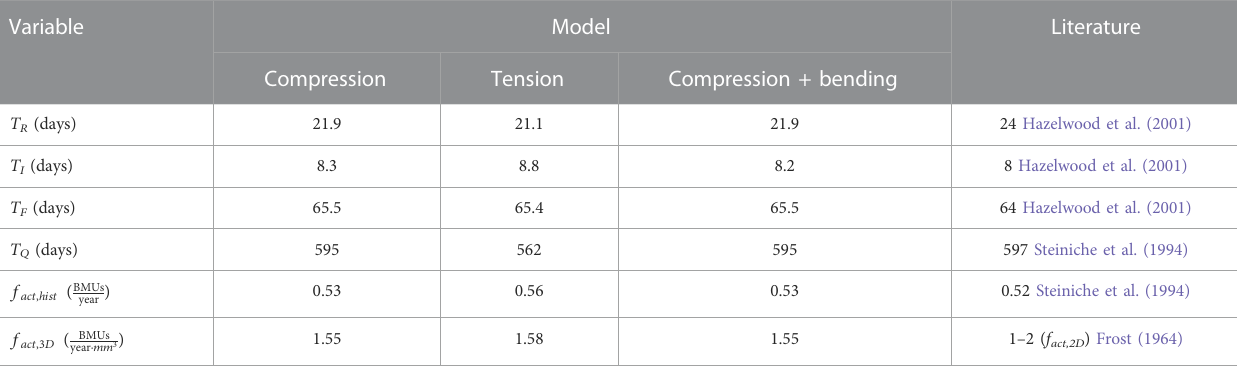
TABLE 2 Duration in days of the different phases of the BMU cycle and activation frequencies obtained for the three load cases. Comparison of the model results and the existing